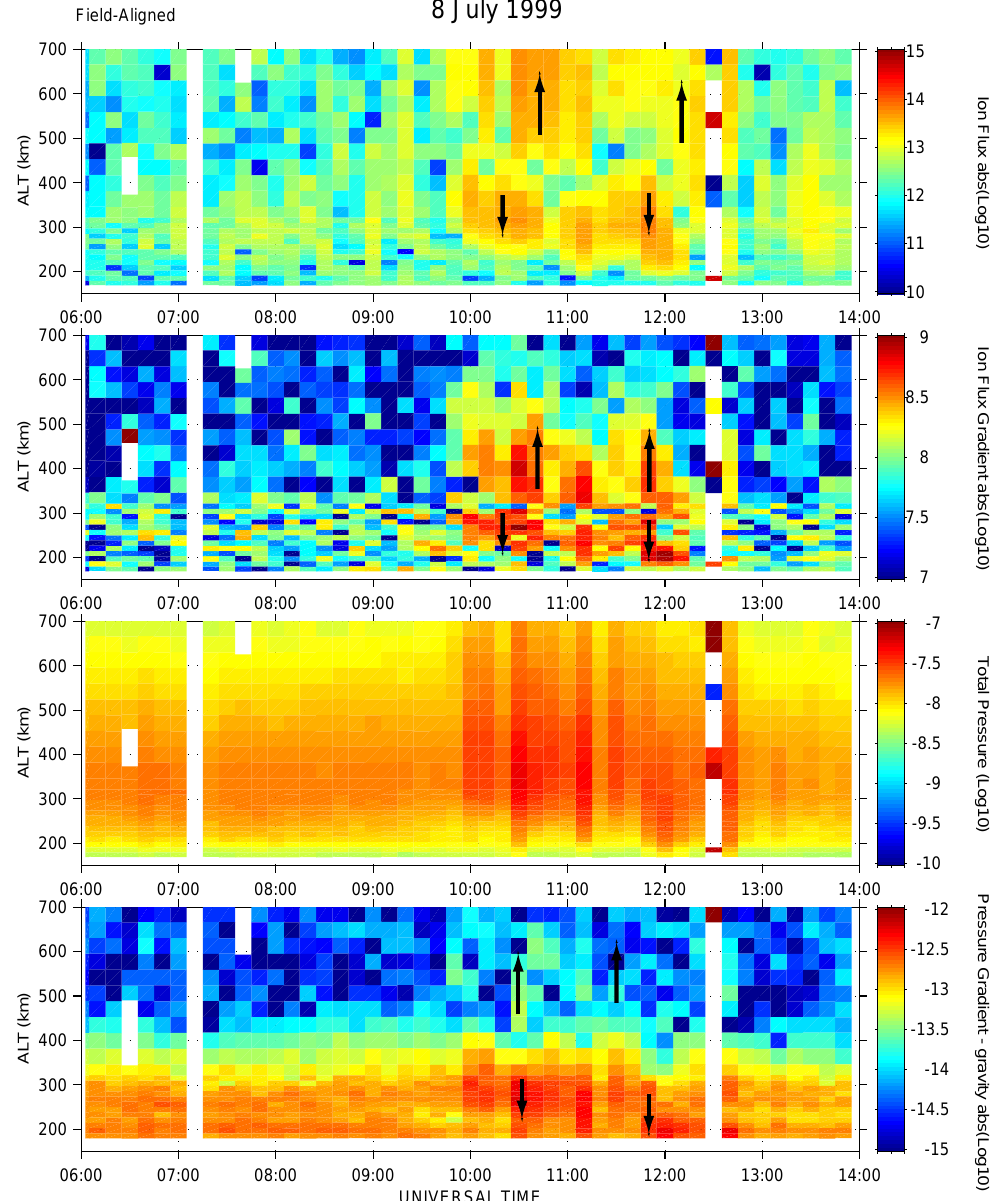
Fig. 5. Shown are parameters derived from the data displayed in Fig. 1. Panels from top to bottom show the absolute value of F i , the flux gradient ∂F i /∂s , the total pressure p = N e k B (T i + T e ) , and the absolute value of the pressure gradient offset by gravity, ∂p/∂s − m i N e g . The parameters are color-coded over altitude (y-axis) and time (x-axis). The directions of the flux and the pressure gradient in the top and bottom panels, respectively, is indicated by black arrows for the sake of